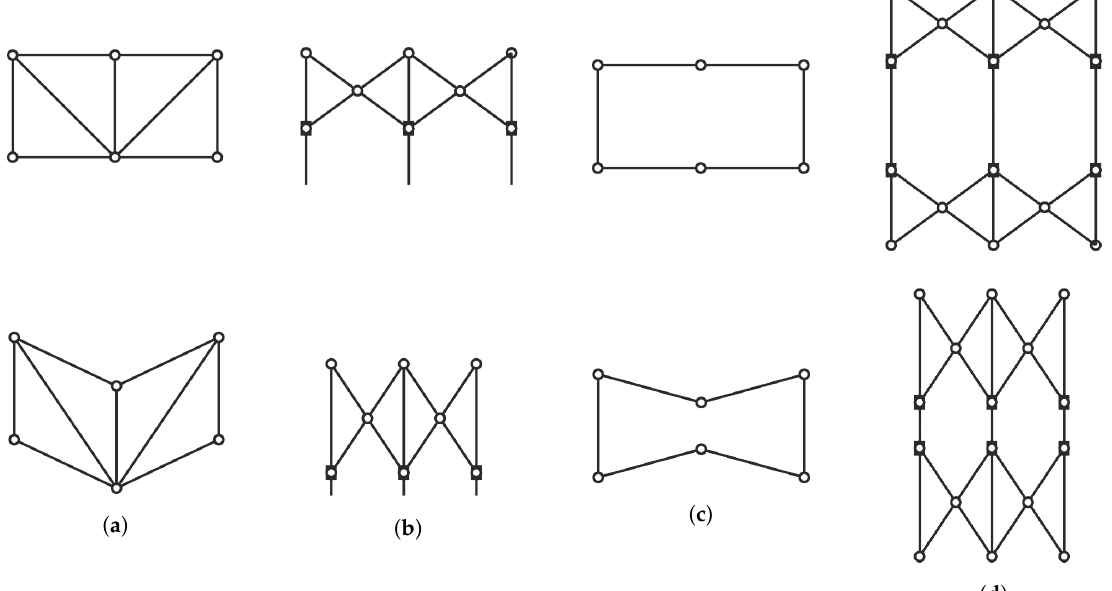
Figure 1. Elementary cells in fully and partially deployed configurations: ( a ) parallelogram with bar or diagonal cable; ( b ) pantograph; ( c ) v-folding rectangle; and ( d ) double vertical